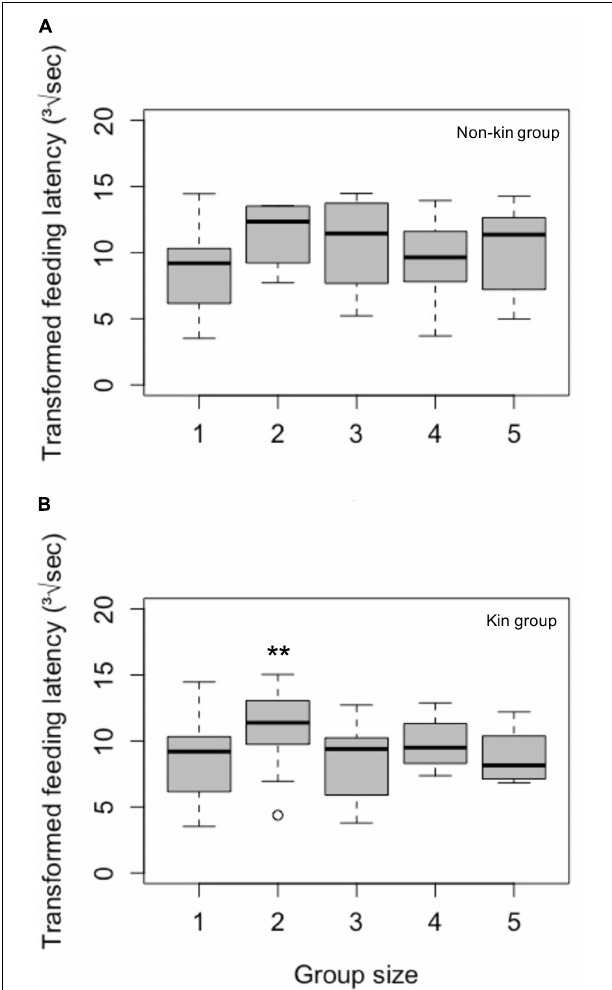
FIGURE 2 | Feeding latency as a foraging cost of (A) non-kin and (B) kin groups in different group sizes. Latencies in the figure are expressed as the absolute difference from the maximum latency (20 min) after taking the cube-root of the raw data). Values of zero on the y-axis denote a raw latency of 20 min; larger values of transformed latency denote shorter raw latency. Results shown that under the conditional model, where cases of no feeding during the observation period (maximum latency) were excluded. While most of the comparisons of feeding latency across group sizes were not significant, group size two in kin groups showed longer feeding latencies, thus higher costs, than other group sizes. Because the data were cube transformed and further transformed raw feeding latency as the absolute difference from the maximum value, larger values here represent shorter latency. The sample sizes were: Group size one: n = 12; group size two: n = 8 for non-kin group and n = 19 for kin group; group size three: n = 8 for non-kin group and n = 7 for kin group; group size four: n = 12 for non-kin group and n = 4 for kin group; group size five: n = 13 for non-kin group and n = 7 for kin group (exclude the data of transformed feeding latency = 0). ** means significant difference between group size one and two at p < 0.01.